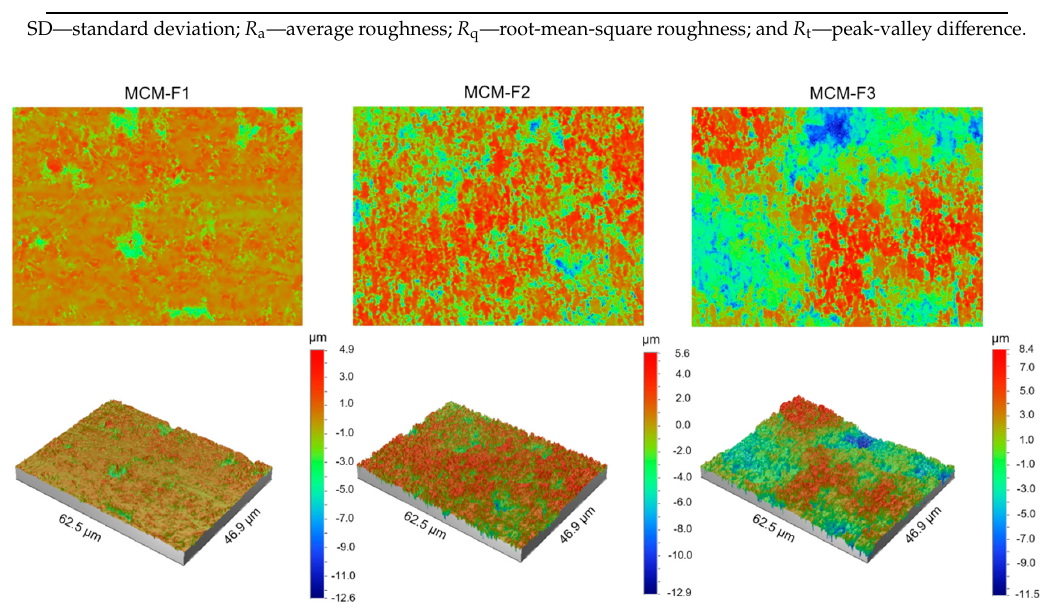
Table 3. Average contact angle and surface free energy ( γ s ) with its dispersive ( γ sd ) and polar ( γ sp )